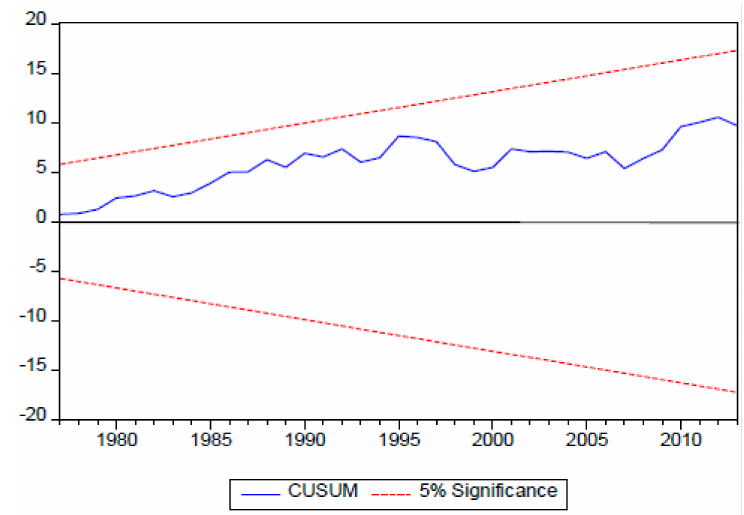
Figure 5. Plot of cumulative sum of recursive residuals for Bangladesh.